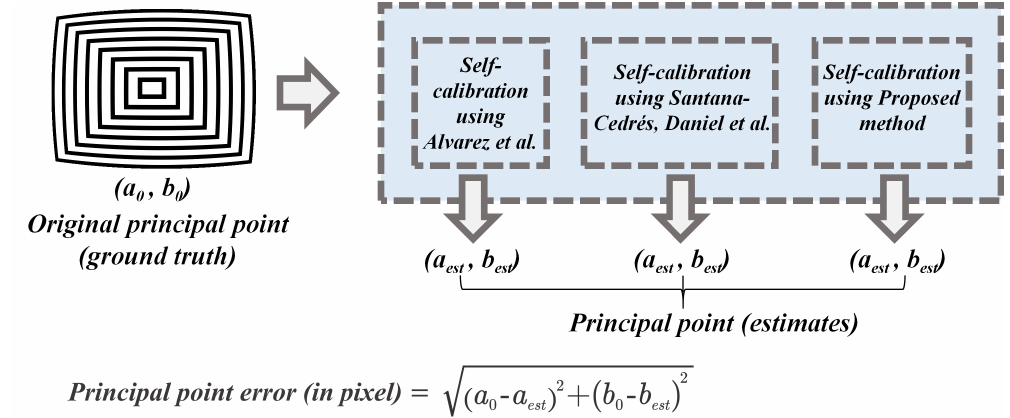
Figure 14. Determining Error in Silent point position (distortion center)